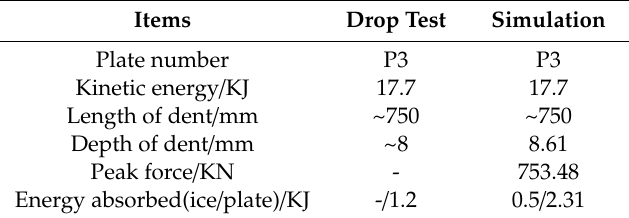
Table 2. Comparison between the simulation and